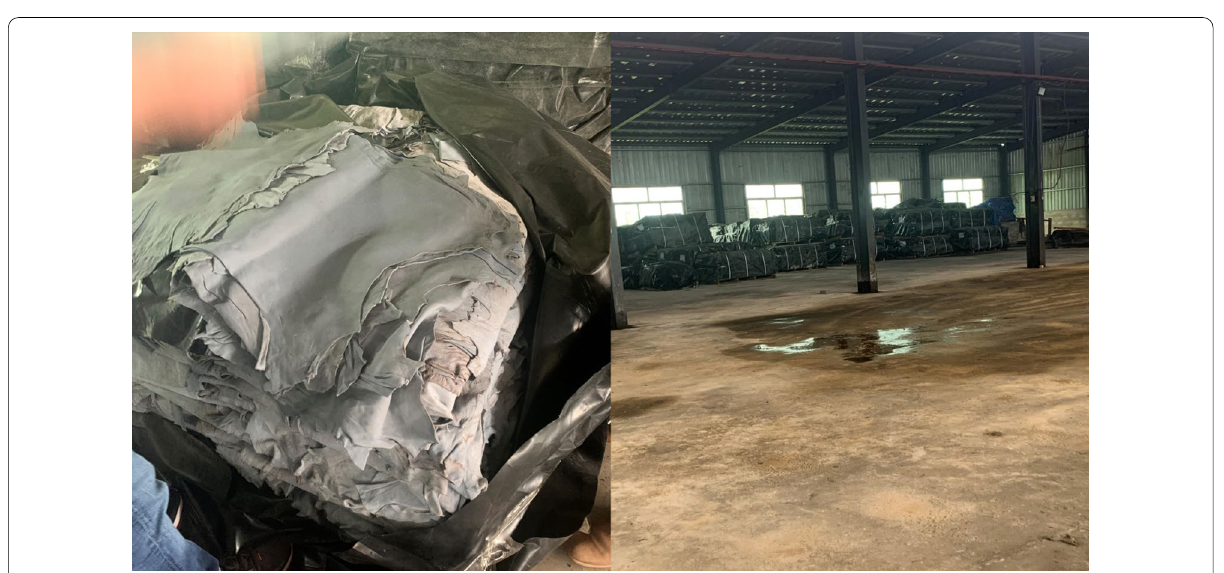
Fig. 4 Stock of wet blue leather in one of the tanneries in Tanzania